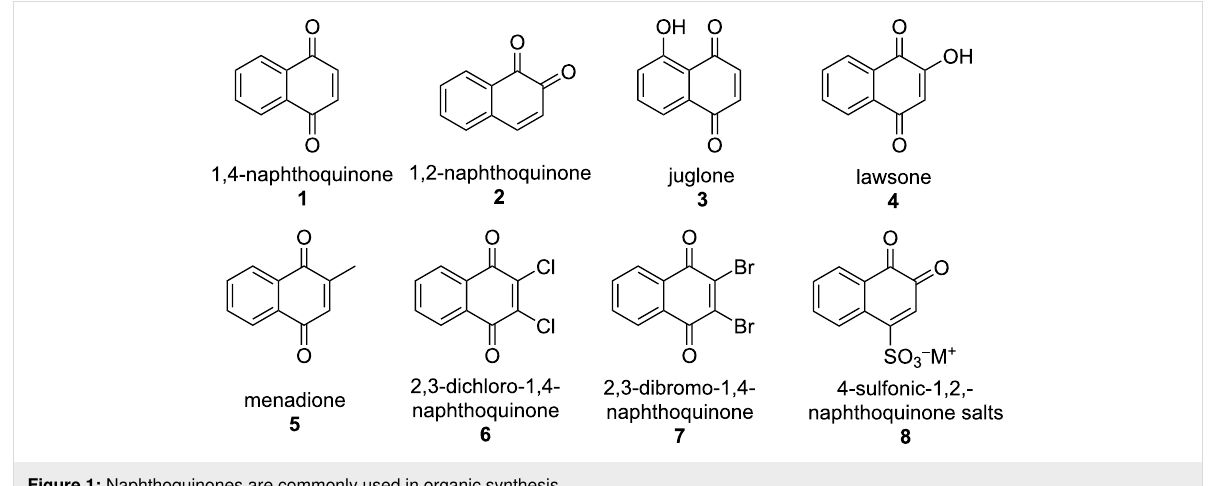
Figure 1: Naphthoquinones are commonly used in organic synthesis.